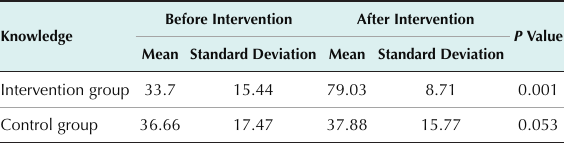
Table 2. Comparison of the Participants’ Attitude About Sex During Pregnancy Before and After the Intervention in the Intervention and Control Group Before Intervention Knowledge